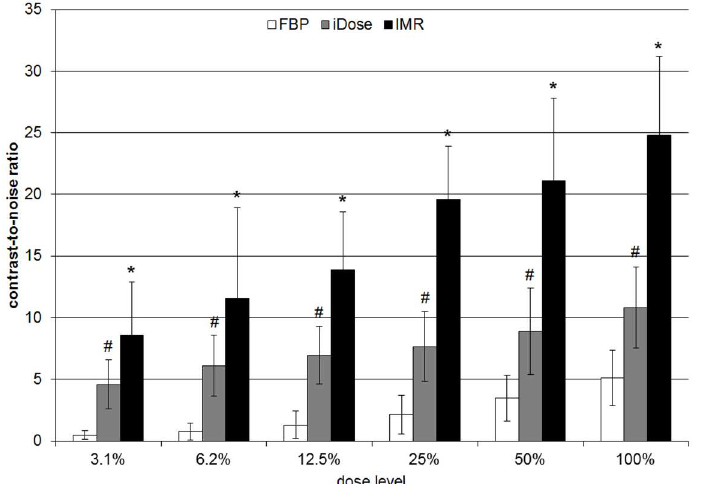
Fig 2. Contrast-to-noiseratio. Contrast-to-noise ratio of a central pulmonary arteryas a centralvessal (cCNR)for all reconstruction algorithms and dose levels shown as mean ± standarddeviation. * = significance comparedto FBP and iDose at the correspondingdose level (p < 0.001).# = significance comparedto FBP at the corresponding dose level (p < 0.001).Significance levels were